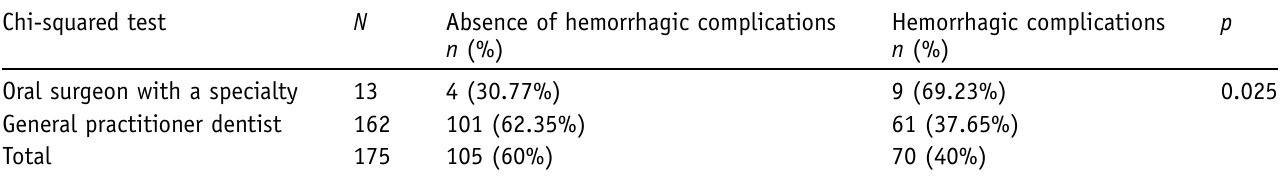
Table II. Onset of the hemorrhagic complications according to the practice pro fi